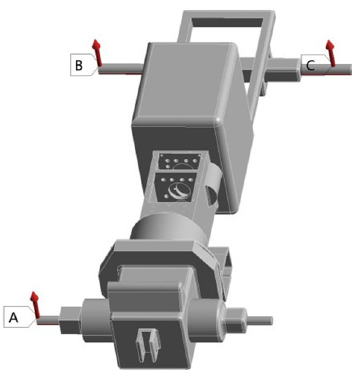
Figure 5. Simplification of box